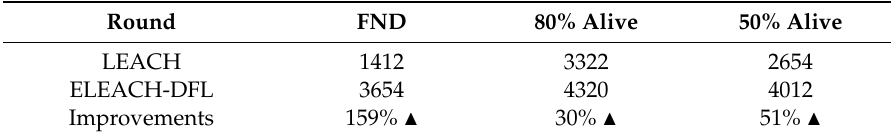
Figure 13. Network lifetime comparison between protocols (base station (BS)): inside the sensor field).